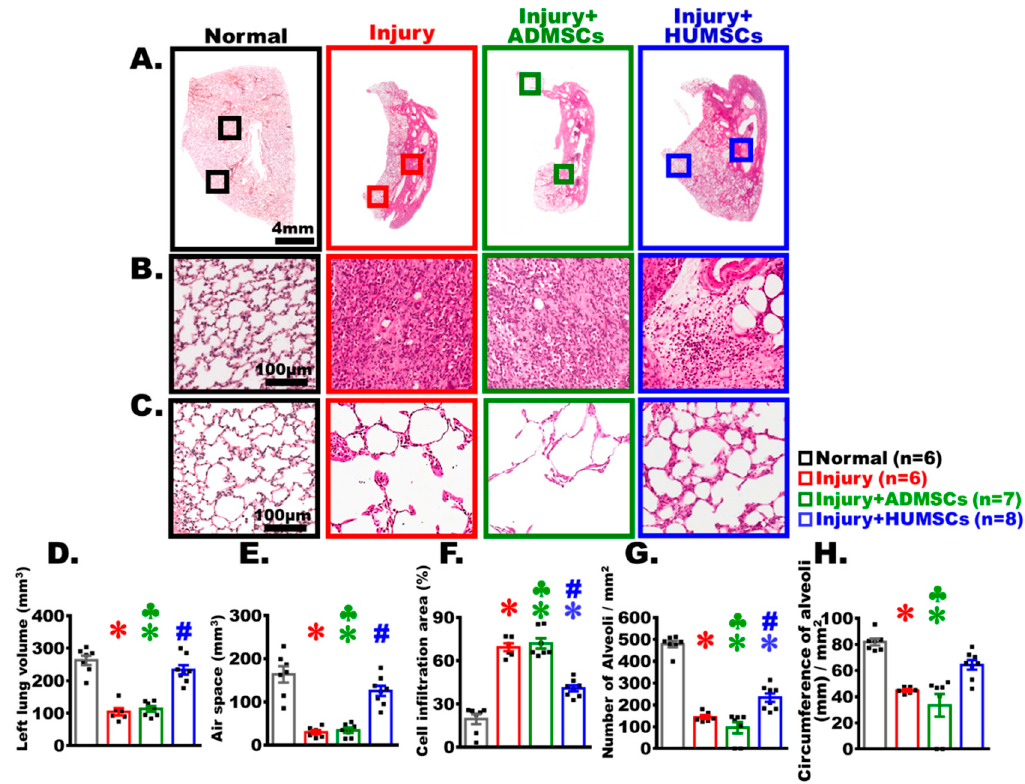
Figure 3. Transplantation of HUMSCs, but not ADMSCs, repaired alveolar structures in PF rats. Lower-magnification photographs of HE-stained left lung sections from each group were acquired on Day 49 ( A ). Photographs with higher magnification demonstrating a significant cell infiltration in the center regions of the left lungs following BLM injury. HUMSCs transplantation, but not ADMSCs transplantation, ameliorated cell infiltration in the central region ( B ). Photographs with higher magnification demonstrated that the alveolar structures were still present in the left lung’s periphery, despite the fact that the size of the alveoli varied ( C ). The total volume of the left lung, calculated by adding data from all HE-stained left lung sections, demonstrated that HUMSC transplantation significantly increased the total volume of the left lung ( D ) and the air space ( E ), while decreasing the cell inflammation areas ( F ). HUMSC transplantation effectively increased the number ( G ) and circumference ( H ) of alveoli per unit area for gas exchange, whereas the left lung structures of the Injury+ADMSCs group were similar to those of the Injury group. The fi gure shows the number of rat samples in each group. ✽ : p < 0.05 (vs. the Normal group); #: p < 0.05 (vs. the Injury group); ♣ : p < 0.05 (the Injury+ADMSCs group vs. the Injury+HUMSCs group).